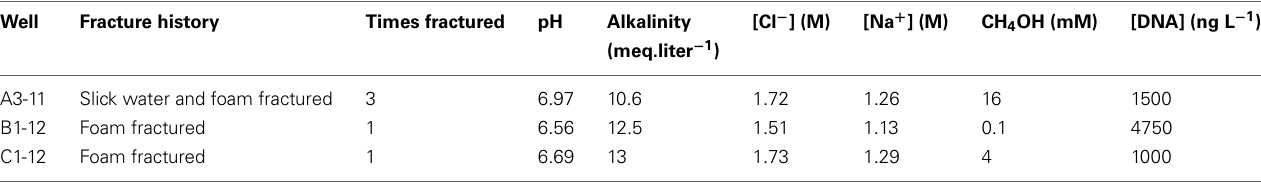
Table 1 | Chemo-physical formation water characteristics and DNA content of the studied wells.